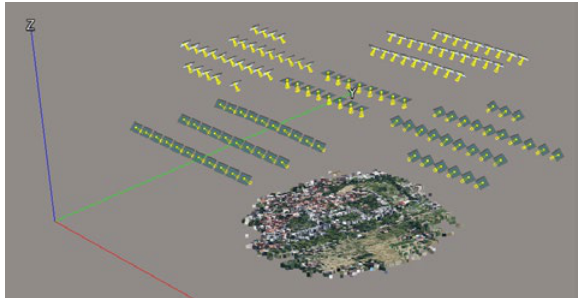
Figure 2. Images acquisition scheme and point cloud generated by ContextCapture.